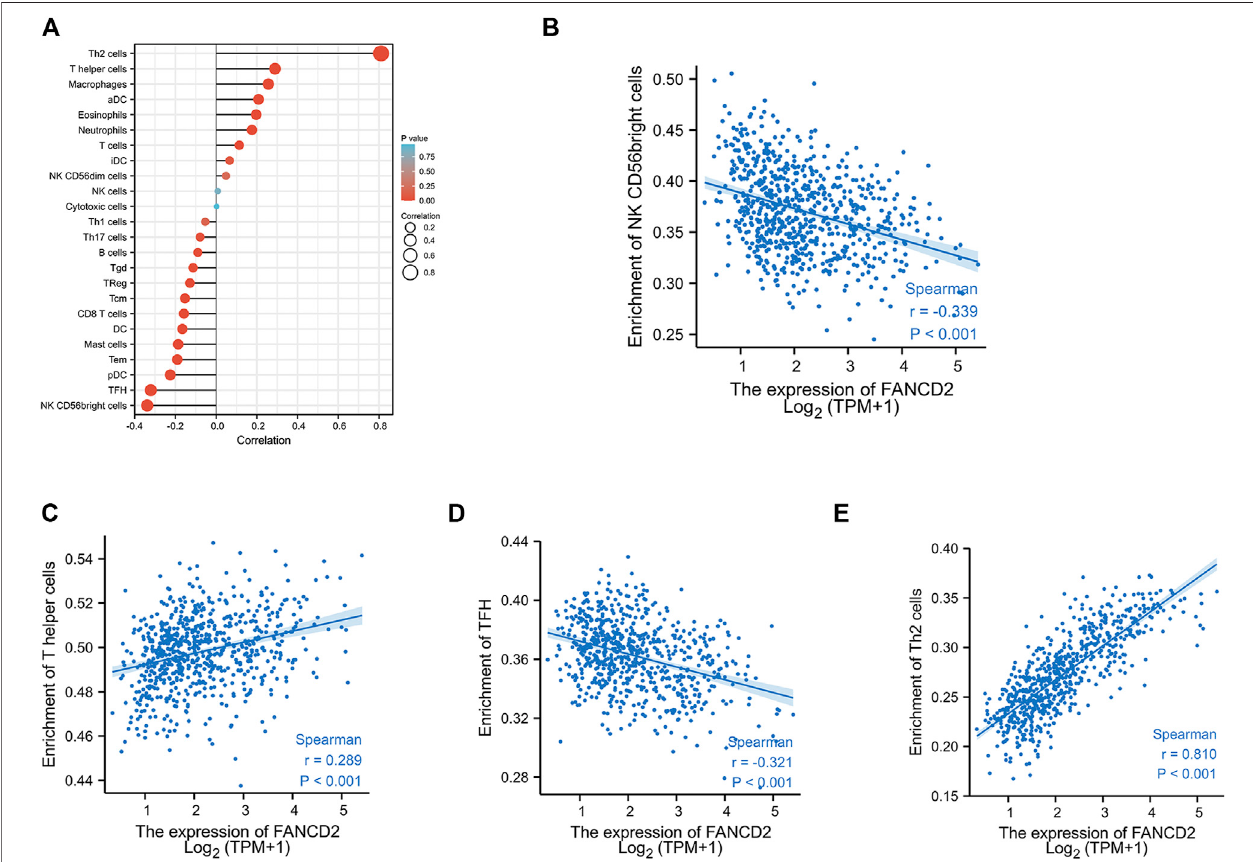
FIGURE6| CorrelationbetweenFANCD2expressionandtumor-in fi ltratinglymphocytesinGBM (A) TheassociationbetweenFANCD2expressionand24typesof immune cells in the TCGA database. Absolute values of Spearman r were measured by the size of round dots (B – E) The scatterplot showed the association between FANCD2 expression and the abundance of tumor-in fi ltrating lymphocytes, including Th2, Th, NK-CD56bright, and TFH